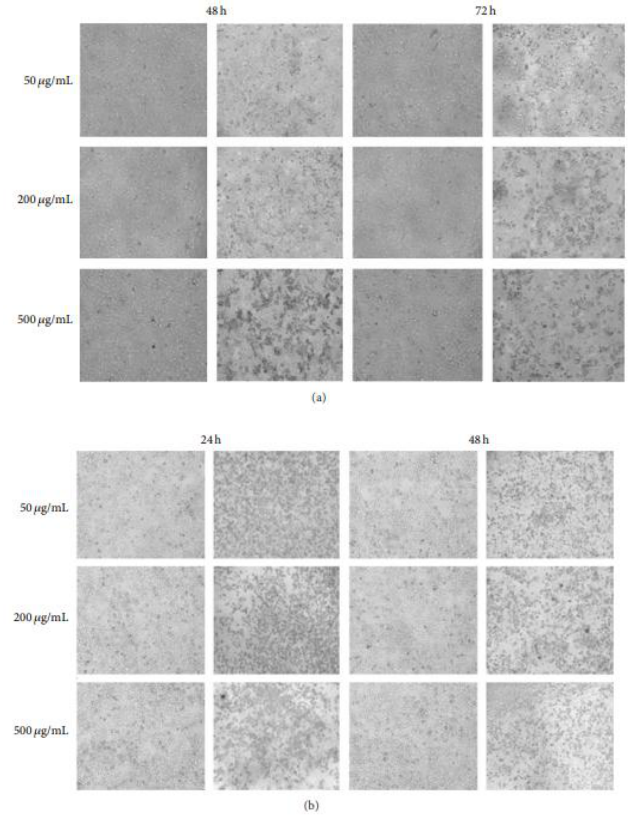
Figure 7: ENLE-induced morphological changes in MCF-7 (a) and HeLa cells (b) at varying concentrations and time-points. 50, 200, and 500 𝜇 g/mL ENLE-treated (a) MCF-7 (for 48 and 72 h) and (b) HeLa cells (24 and 48 h) showed dose- and time-dependent increase in